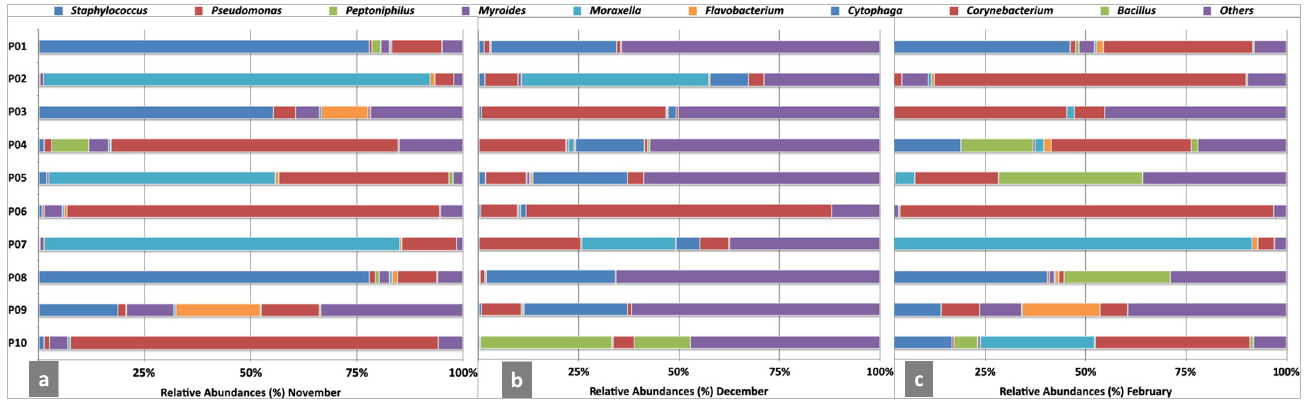
PLOS ONE | https://doi.org/10.1371/journal.pone.0260314 November24,